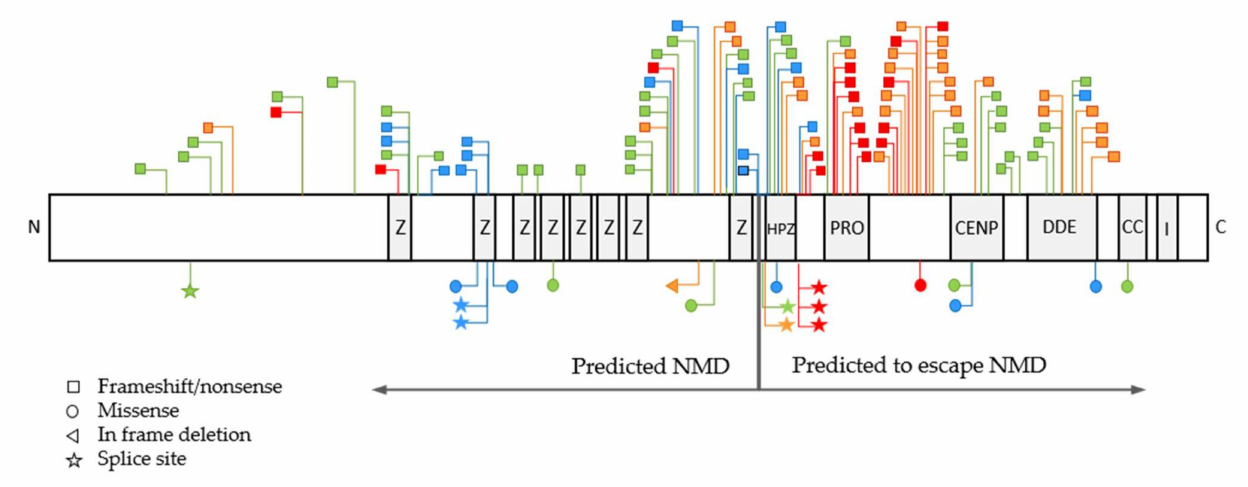
Figure 3. Distribution of variants in POGZ domains. NMD: nonsense-mediated RNA decay; CENP- binding: Centromere protein (CENP)-B-DNA-binding domain; DDE: originated from a transposase encoded by a pogo-like DNA transposon; Z: zinc finger domains 1-8; HPZ: HP1-binding zinc finger- like domain (zinc finger domain 9); CC: coiled coil domain; I: Integrase domain-binding motif. Severity score 1: blue, severity score 2: green, severity score 3: orange and severity score 4: red. Variant descriptions are detailed in Supplementary Table S1. Variants with discrepant labelling of severity (e.g., red-labeled variant in the N-terminal domain or zinc finger 1 domain) originate from cohort 3 with less detailed phenotypes.